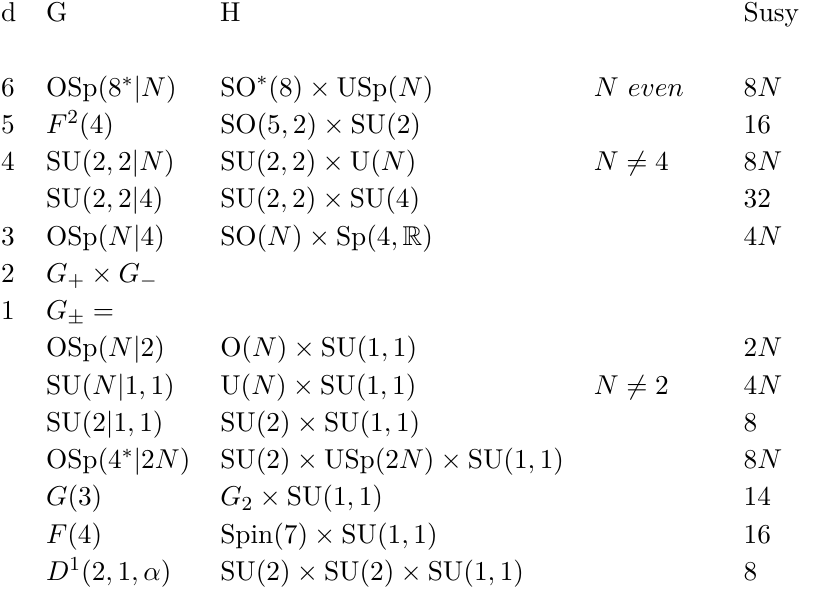
Table 1 . Following [15, 16] we list the AdS supergroups in d ≤ 6 and their bosonic subgroups in the notation of